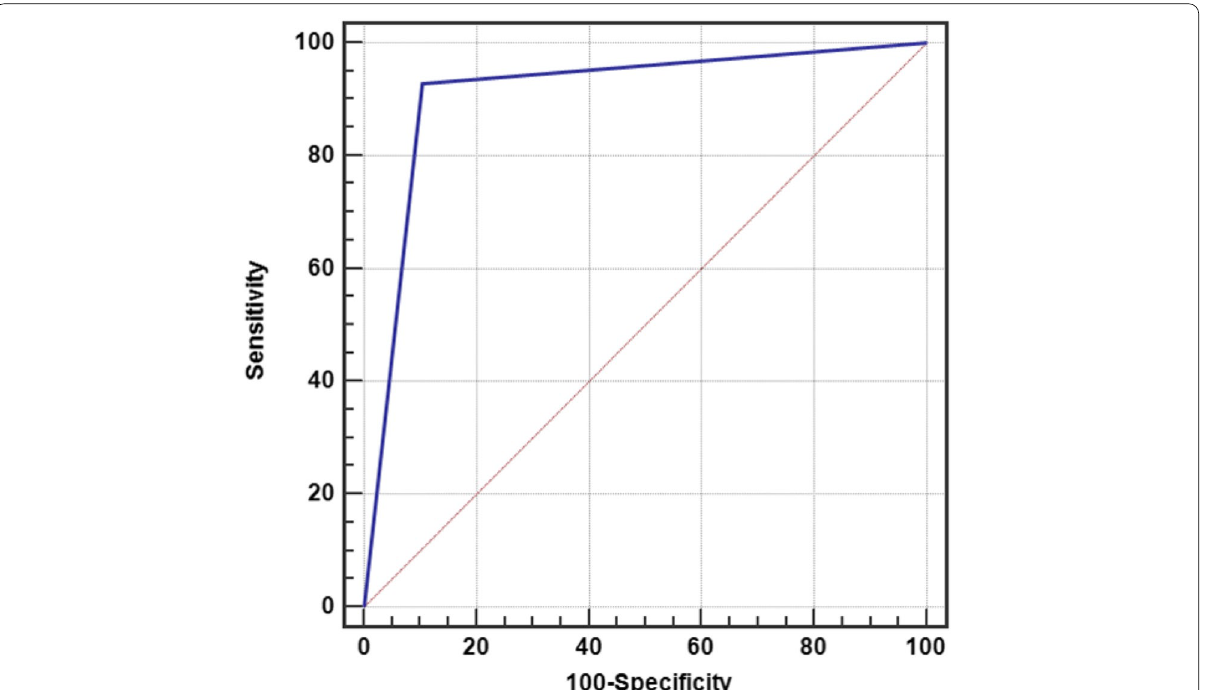
Fig. 1 Receiver operating characteristic (ROC) curve for Pleural Adherence Score for predicting successful pleurodesis